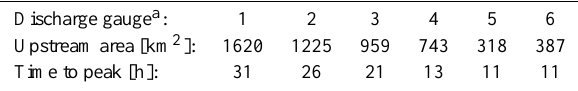
Table 1. Catchment response time between the catchment averaged rainfall centroid and the discharge